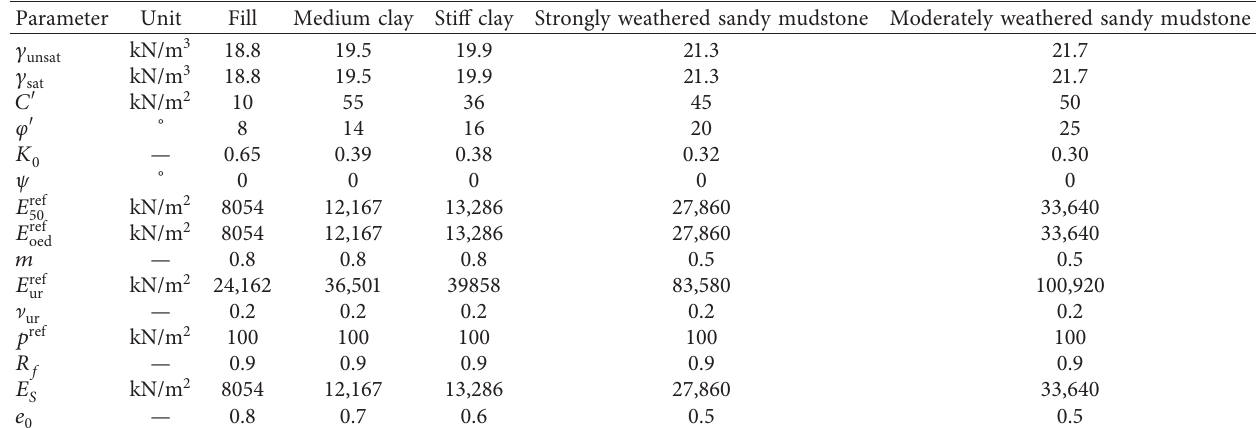
Figure 12: GDS equipment (a) and prepared specimens (b). Table 6: The parameters of the HS